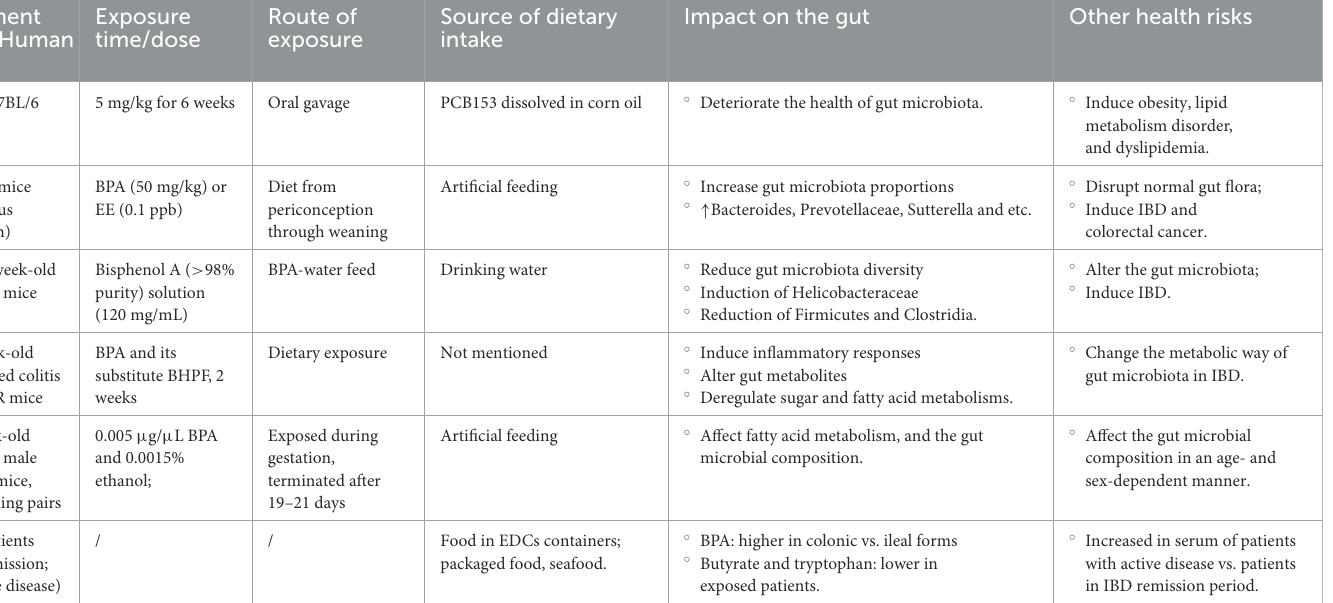
TABLE 2 Adverse health effect of EDCs in inflammatory bowel